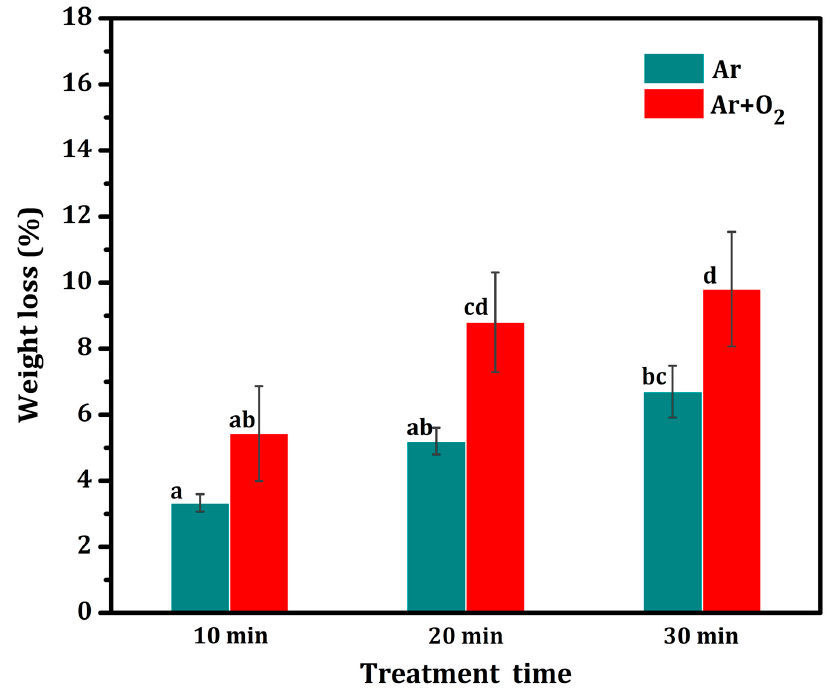
Figure 7. Comprehensively reduced weight loss percentage of fiber surface treated with plasma at various treatment times compared with the untreated fiber. Note: values indicated with the same letters are not significantly different at p ≤ 0.05.